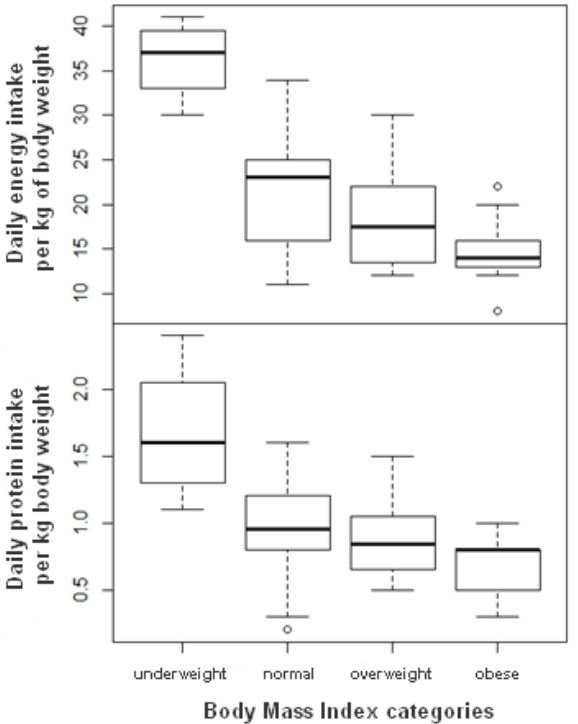
Figure 1. The boxplots of daily energy and protein intakes relative to body weight (DNIs) by weight status (BMI) of participants.